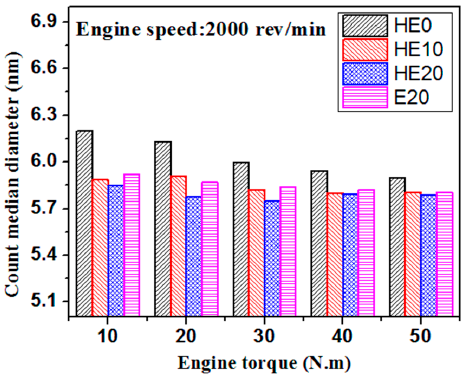
Figure 9. Variation of count median diameter with engine load.